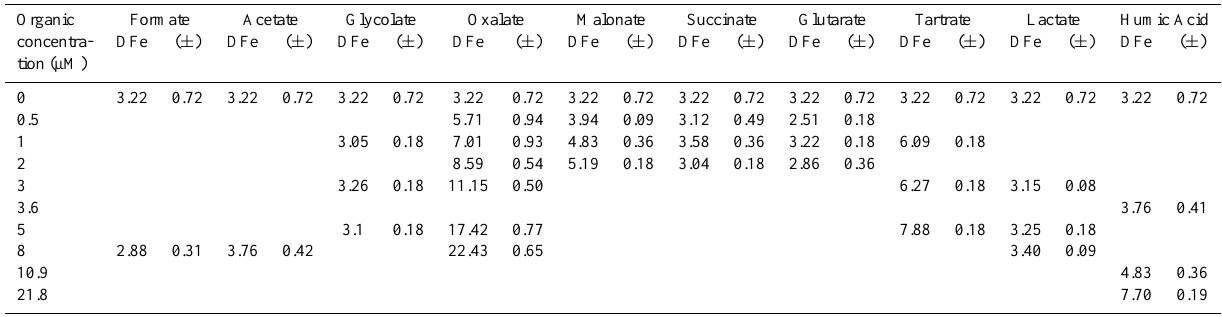
Table 2a. Dissolved iron concentrations (nM) obtained for the dissolution experiments from Niger dust at pH 4.7 and for various atmospheric concentrations of organic ligands.